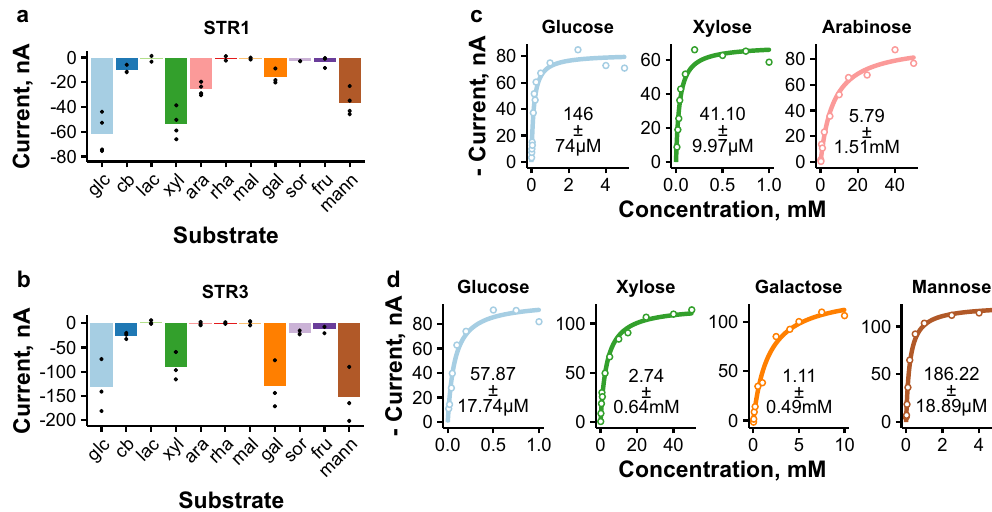
Figure 2. Electrophysiological characterization of d-glucose transporters STR1 and STR3. ( a , b ) Selectivity plots of STR1 ( a ) and STR3 ( b ) measured by recording currents in the presence of different sugars in 5 mM concentration (abbreviations as in Fig. 1). Results obtained with − 50 mV test voltage are shown. Points present results obtained from individual oocytes and bars their mean ( n ≥ 3 ). ( c , d ) Sugar transport kinetics of STR1 ( c ) and STR3 ( d ) at − 50 mV. Representative experiments are shown. Lines present the Michaelis Menten kinetics prediction and the K m values present the mean and standard deviation from individual oocytes ( n = 3 , except n = 5 for d-glucose kinetics of STR3). The figure was created with ggplot2 package (version 3.3.2) for R 79,85